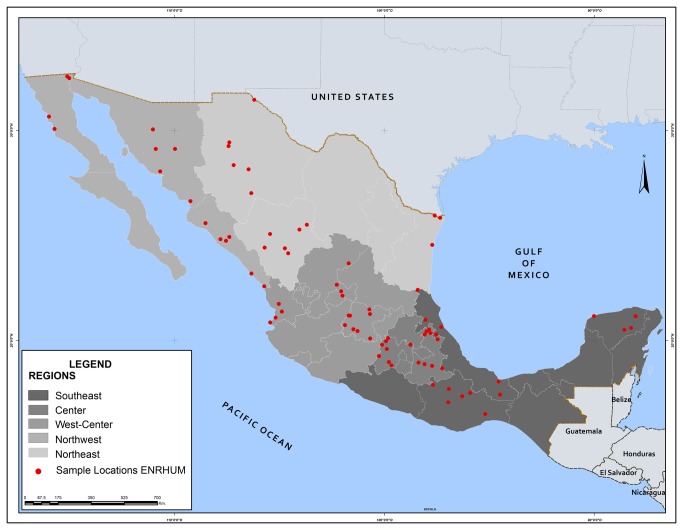
ENHRUM survey regions and locations.The Mexico Rural Household Survey (ENHRUM) is the source of primary data on the management of maize seed used in all analyses. ENHRUM is based on a stratified, three-stage, cluster sampling frame designed in collaboration with INEGI, the Mexican census bureau. A sample of states, localities and households (i.e., primary, secondary and elementary sample units, respectively), was selected through simple random sampling at every stage in each of the regions considered by INEGI. The sample is representative with 95% confidence of the rural population nationwide and in each region.